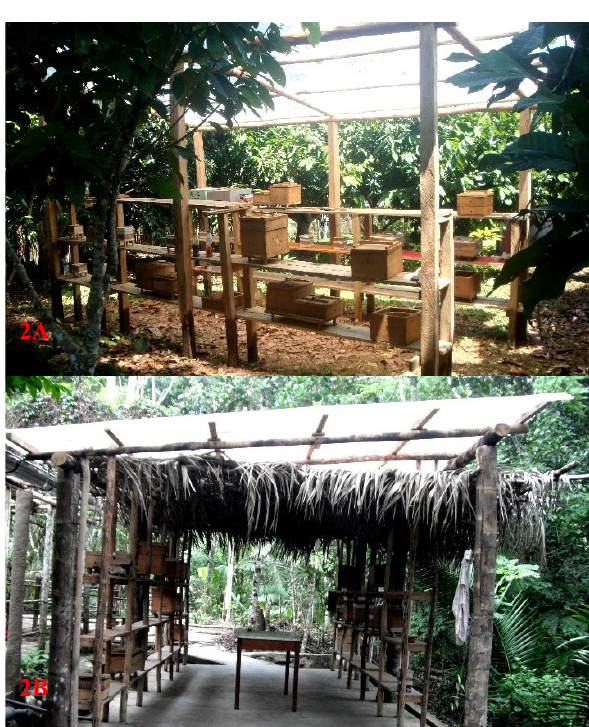
Figure 2. 2.A Meliponario Chasuta. 2.B Meliponario